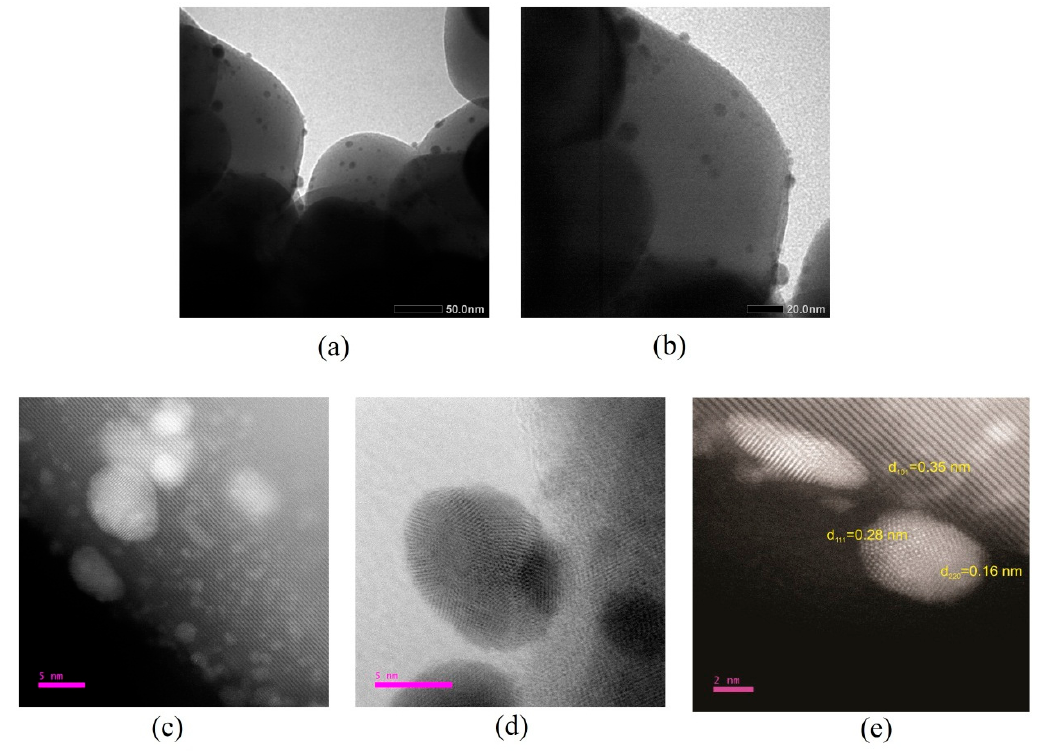
Figure 6. TEM images of Ag/TiO 2 2% ( a , b ) and TEM images of Ag/TiO 2 4% ( c – e ).